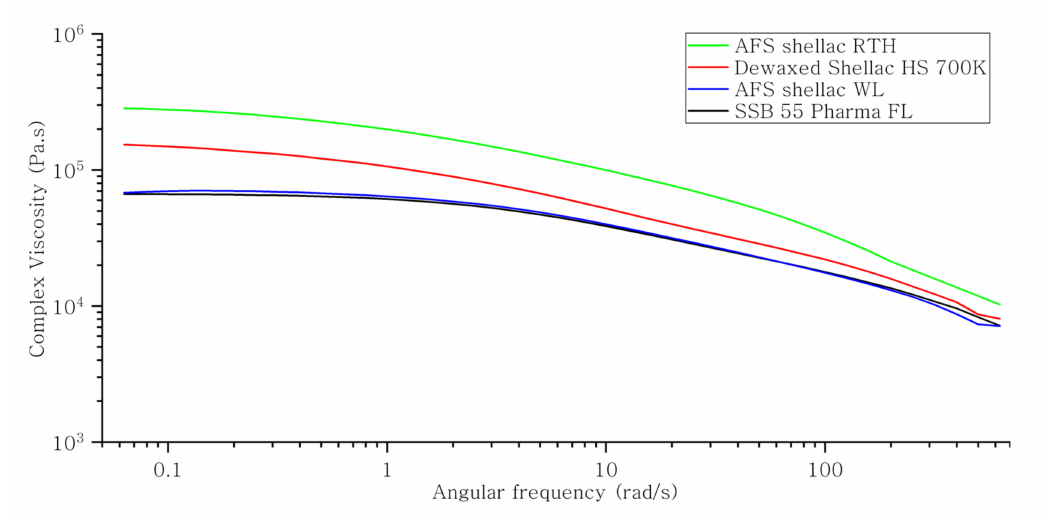
Figure 3. Complex viscosity versus frequency of various shellac in frequency sweep at 70 ◦ C.